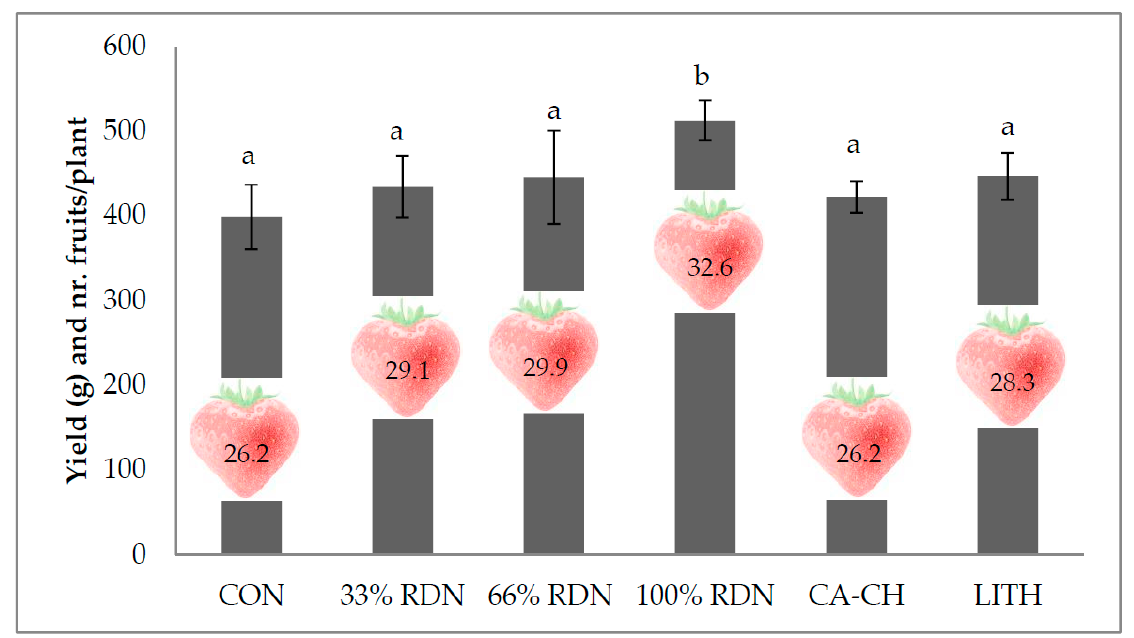
Figure 1. Strawberry yield and average number of fruits per plant following six treatments (33%, 66% and 100% of RDN, CA-CH, LITH and CON). Average means ( n = 10) ± standard errors are shown. Different letters between treatments denote significant differences (Tukey test, p < 0.05). RDN—recommended dose of nitrogen; CA-CH—calcium chelate; LITH—Lithovit; CON—control.